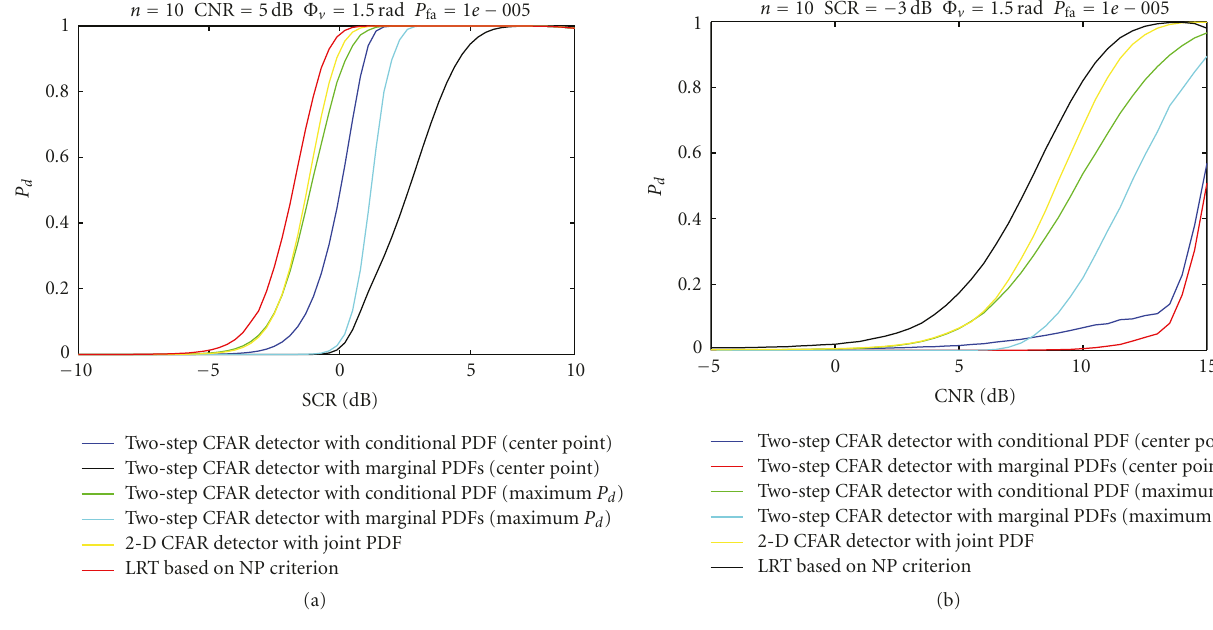
Figure 8: P d of ATI detectors versus SCR and CNR for n = 10, P fa = 1 e − 5, and Φ v = 1 . 5 rad, (two-step CFAR detector with conditional PDF (center point/maximum P d ), two-step CFAR detector with marginal PDFs (center point/maximum P d ), 2D CFAR detector with joint PDF, and LRT based on NP criterion). (a) CNR = 5dB; (b) SCR = 0 dB.